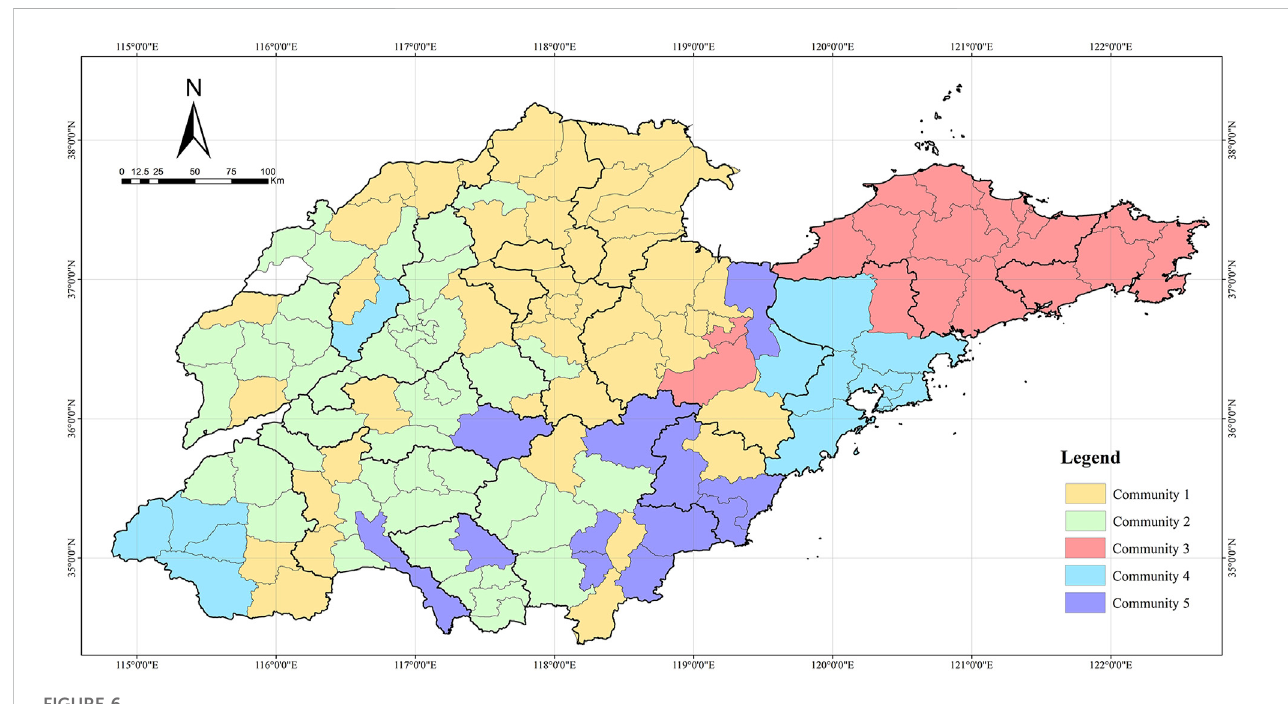
FIGURE 6 Distribution of Network Community of City Supply Networks in Shandong.